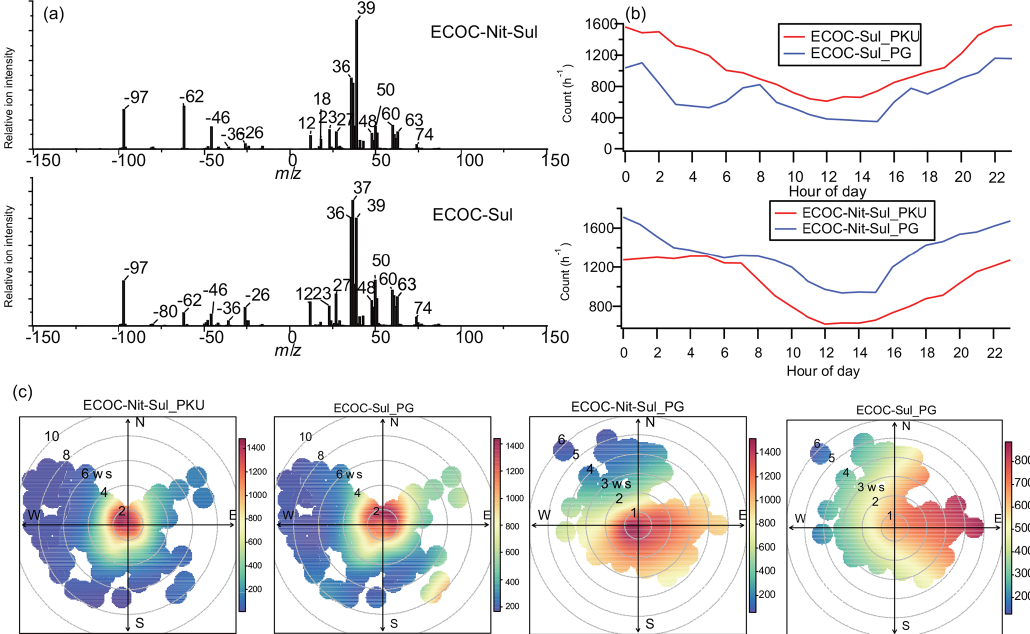
Figure 5. (a) Average mass spectra of ECOC-Nit and ECOC-Nit-Sul observed at both sites; (b) diurnal patterns of the hourly count of ECOC-Sul and ECOC-Nit-Sul at both sites; (c) polar plots of ECOC-Sul and ECOC-Nit-Sul; the gray circles indicate wind speed (ms 1 ).